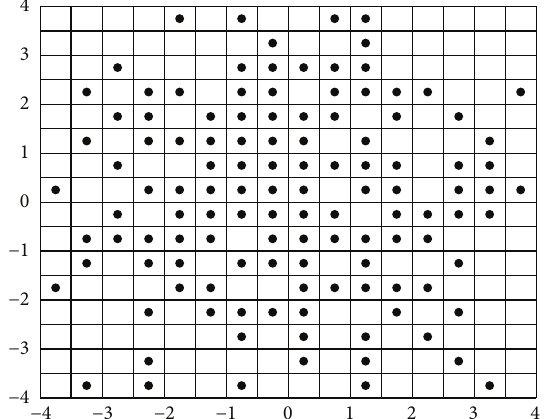
Figure 8: Array configuration for 120